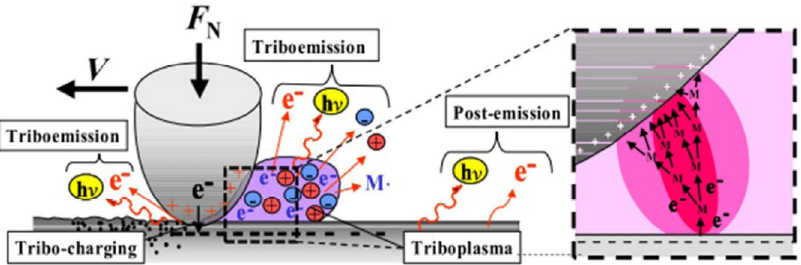
Fig. 13 Model of triboplasma generation through discharging of gas owing to triboelectrification [46, 47, 50]. Reproduced with permission from Ref. [46]. Copyright Elsevier, 2004. Reproduced with permission from Ref. [50]. Copyright Elsevier,